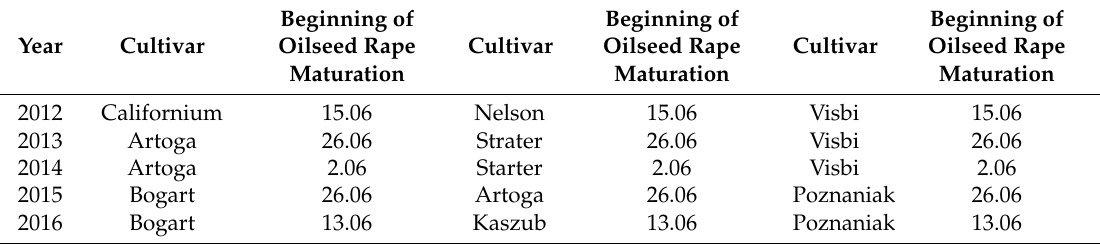
Table 9. Dates of the beginning of maturation of oilseed rape cultivars in the years of